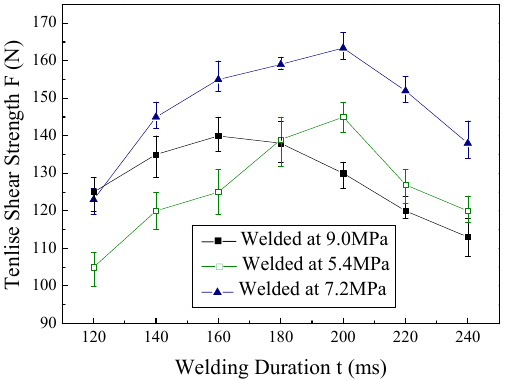
Figure 2. The tensile shear test results: strength vs. welding duration and static pressure.